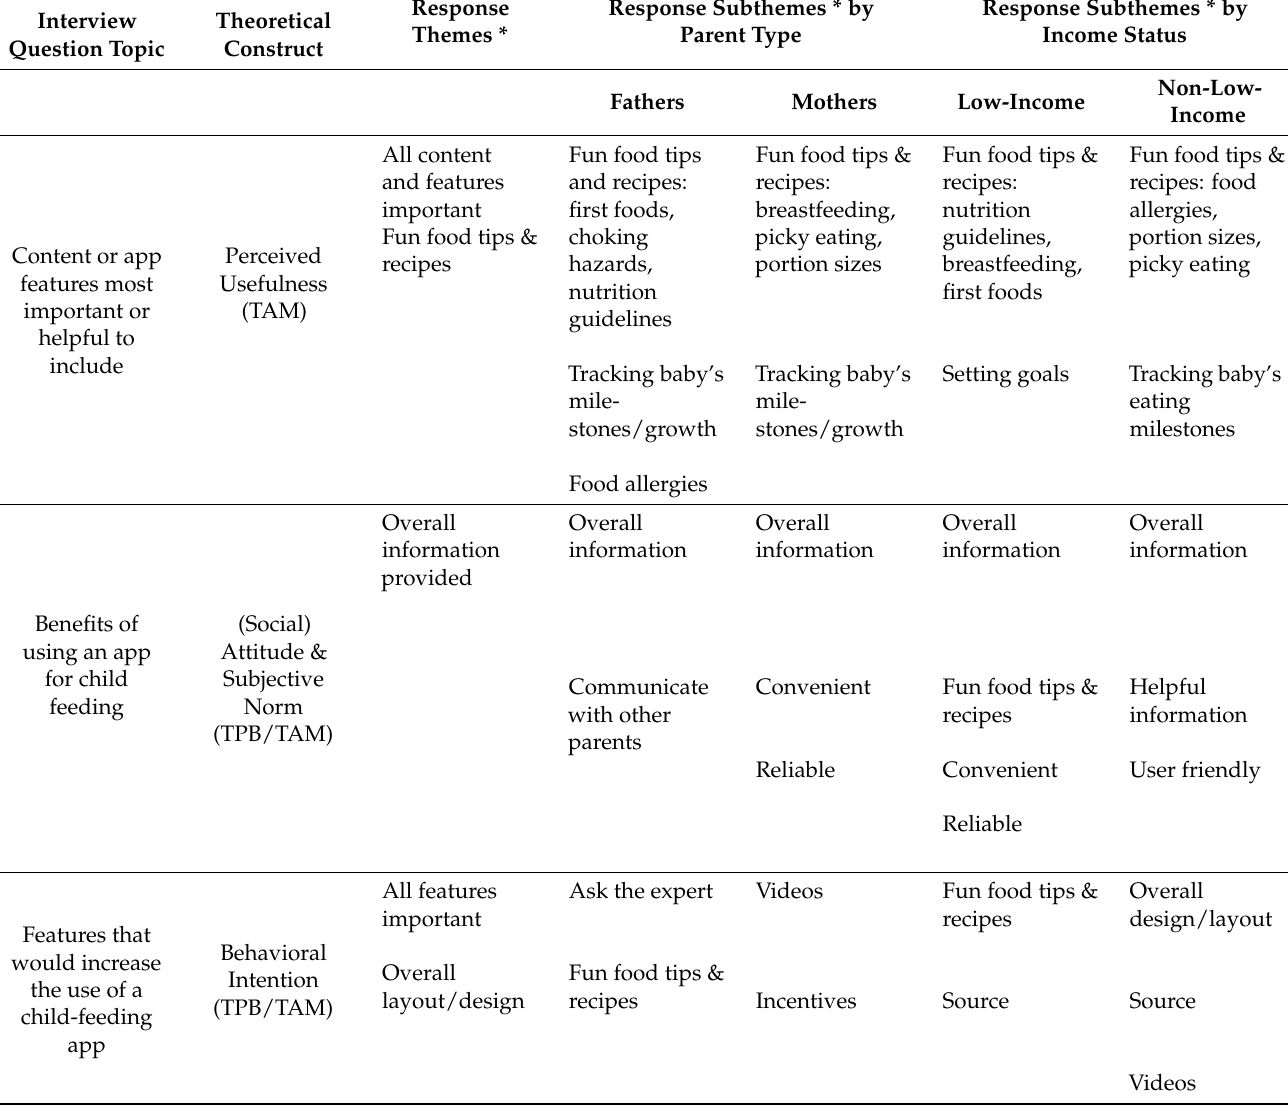
Table 2. Qualitative interview question topics and response themes and subthemes from parents ( n = 40) of children ages 0–2 years old to guide the development of a mobile phone application (mHealth app) containing early child feeding and obesity prevention educational